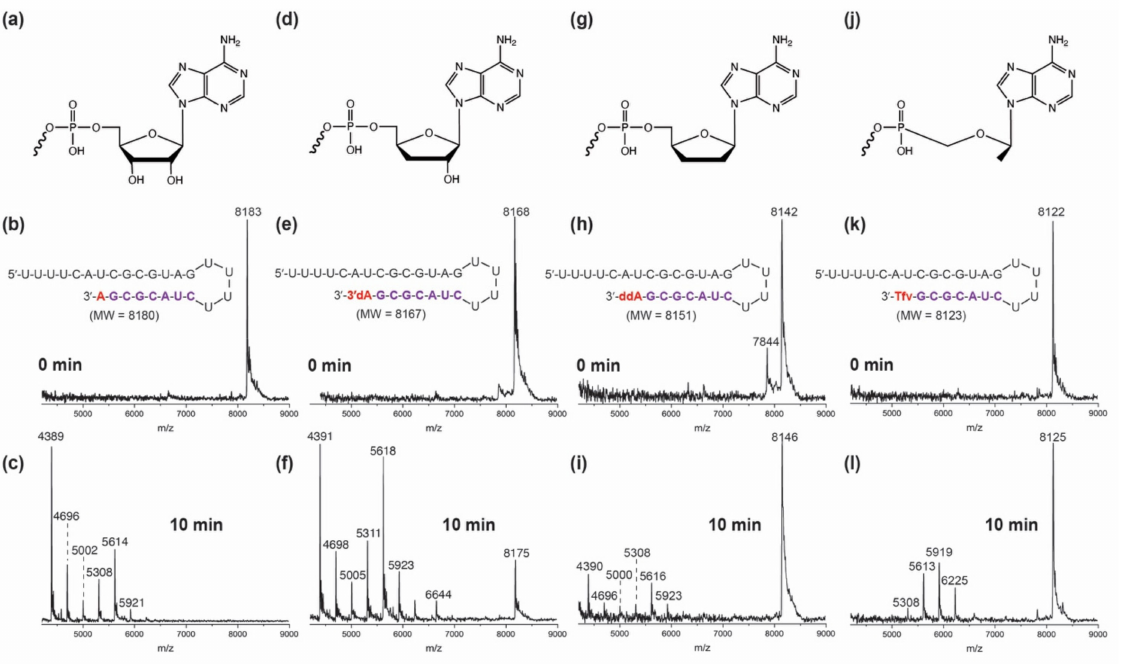
Figure 2. SARS-CoV-2 exonuclease activity with adenosine- or adenosine analogue-terminated RNA. A mixture of 500 nM template-loop-primer terminated at its 3 (cid:48) end with either A ( a ), Cordy- cepin ( d ), ddA ( g ) or Tenofovir (Tfv) ( j ) (sequences shown in b , e , h , k ) and SARS-CoV-2 pre-assembled exonuclease complex (Nsp14/Nsp10) was incubated at 37 ◦ C for 10 min. These intact RNAs ( b , e , h , k ) and their respective exonuclease reaction products ( c , f , i , l ) were analyzed by MALDI-TOF MS. The signal intensity was normalized to the highest peak. The accuracy for m / z determination is approxi- mately ± 10